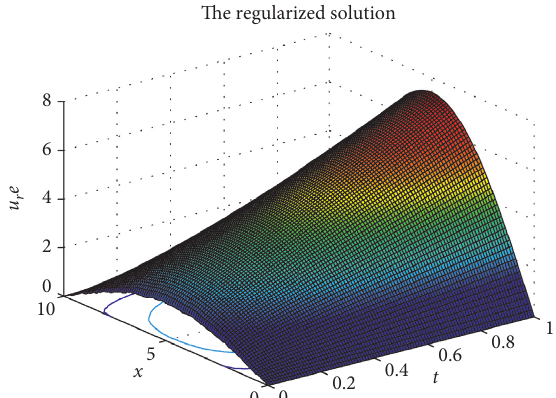
Figure 7: The regularized solution u ε , c 2 with ε � 10 − 3 and c